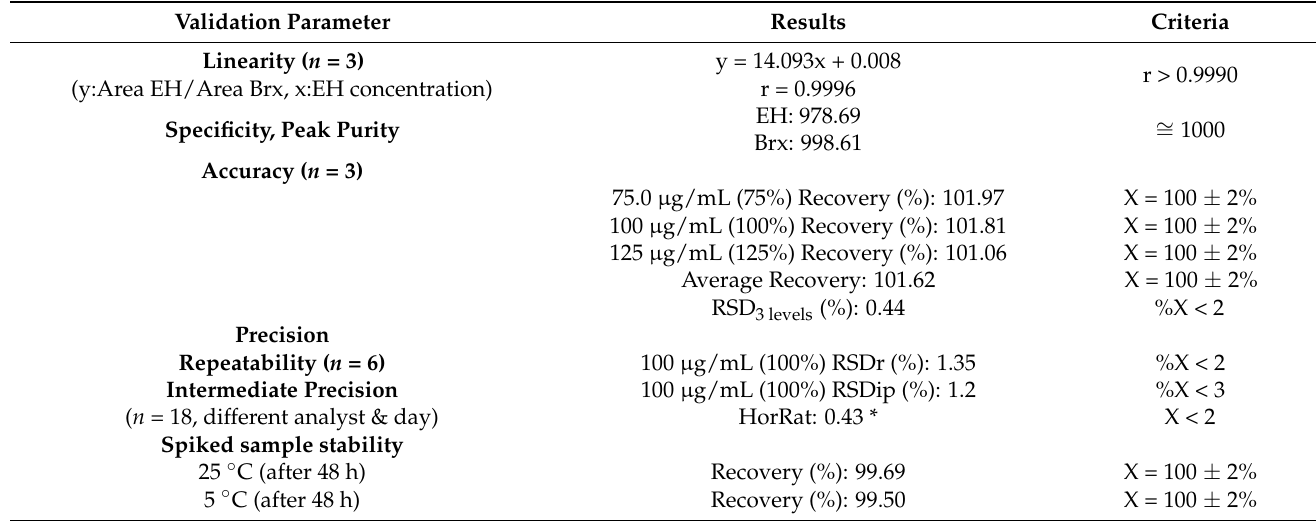
Table 4. Validation results of HPLC method for quantitation of EH in ointment.